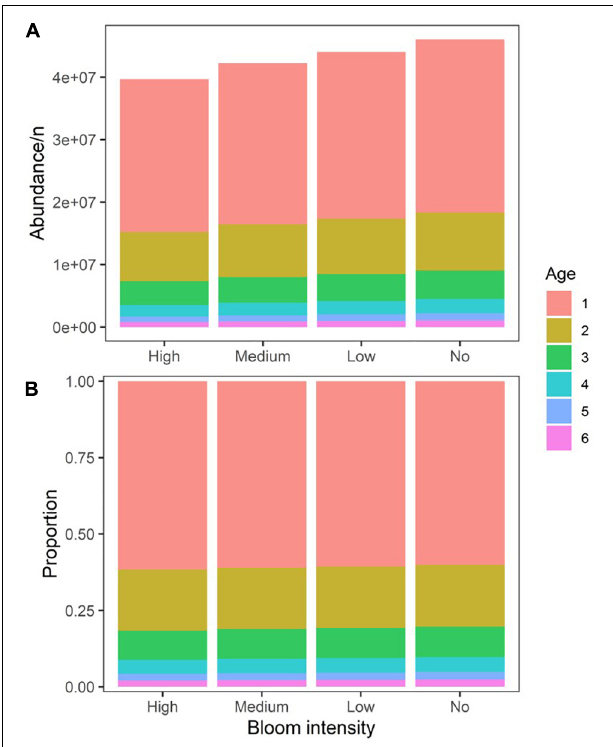
FIGURE 8 | The final abundance-at-age (A) and age-structure (B) under different green tide bloom